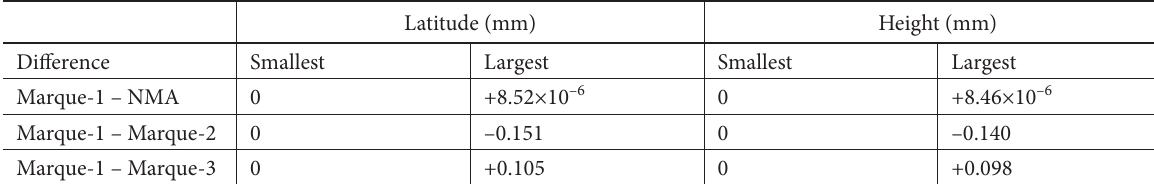
Table 2. The differences in latitude and height